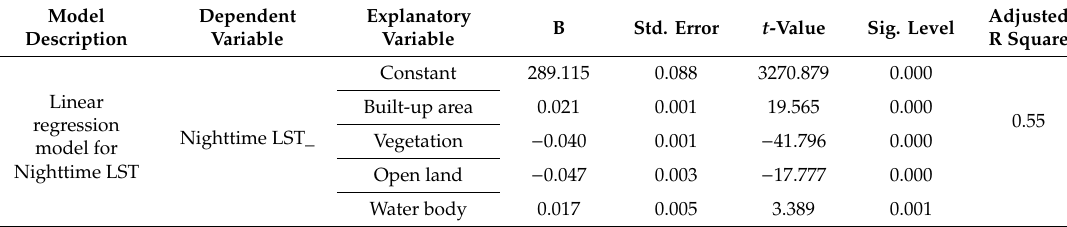
Table 4. Results of regression analysis.